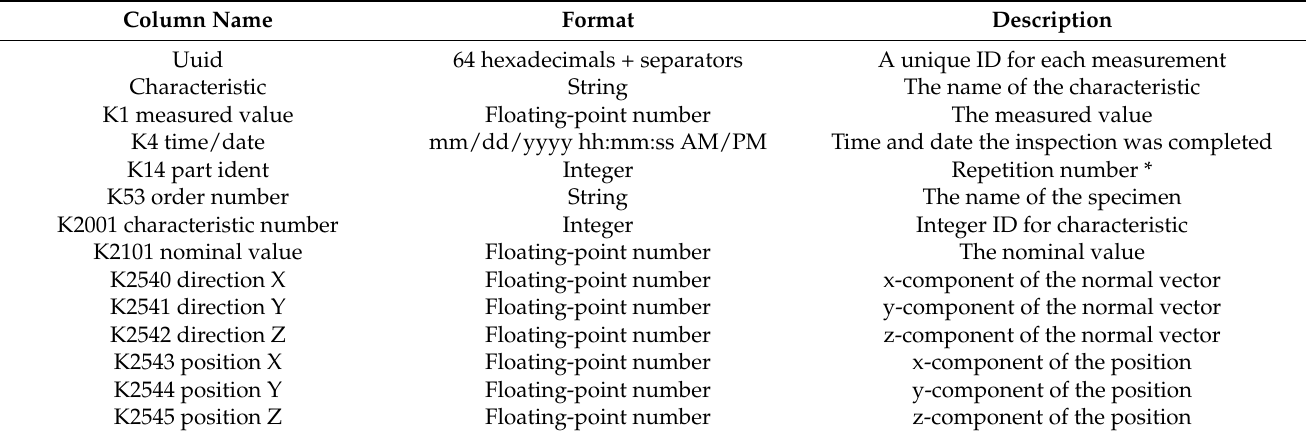
Table 7. Column descriptions for comma-separated values (CSV)